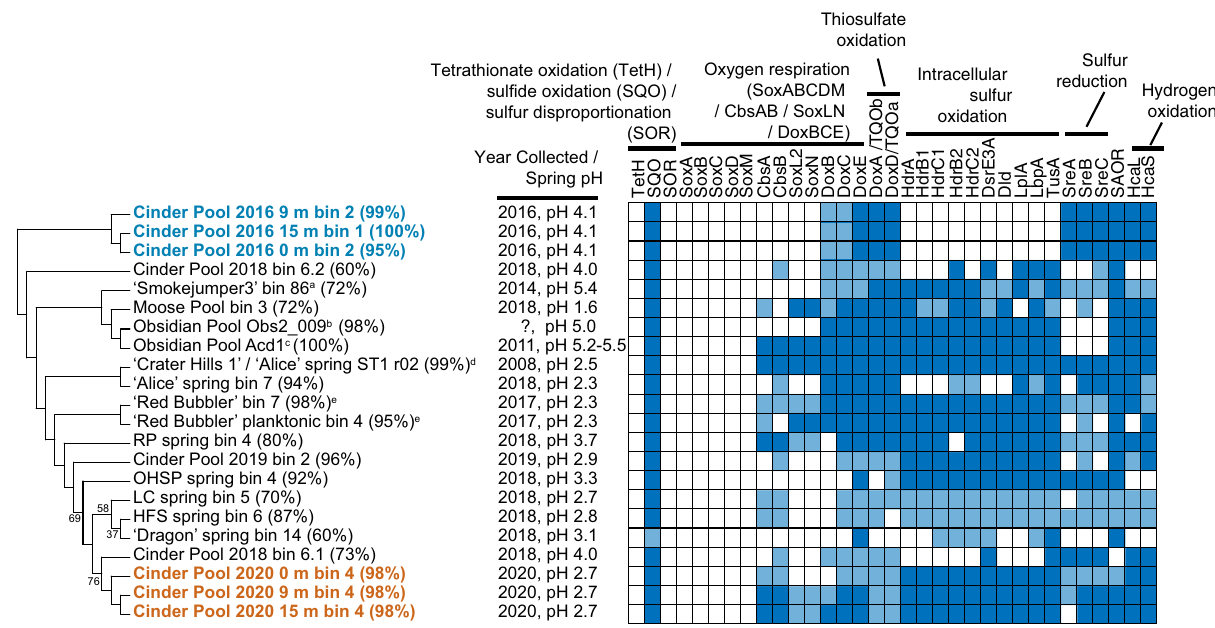
Fig. 5 Metabolic reconstructions of uncharacterized Sulfolobales metagenome-assembled genomes (MAGs) recovered from Cinder Pool (CP) and other Yellowstone National Park (YNP) hot springs. Uncultured Yellowstone Sulfolobales (UYS) MAGs are shown in a cladogram on the left in the same order as the phylogenomic tree in Fig. 4a. MAGs recovered from CP waters in 2016 are highlighted in blue and those from 2020 are highlighted in orange. MAGs with superscript labels were recovered from YNP hot spring sediments in previously published studies as follows ( a 33 ; b 35 ; c 34 ; d 32 ; e 26 ; note the single MAG generated from a water community of ‘ Red Bubbler ’ spring). All other MAGs were recovered from YNP hot spring sediments as part of our other studies. The name of the spring is given fi rst, followed by the MAG identi fi er, and the estimated completeness of the MAG is in parentheses. The year of sample collection and spring pH is given in the column in the middle. The heatmap to the right of the labels shows the presence of genes encoding proteins involved in sulfur cycling within each MAG, with protein names and functions listed at the top of the heatmap. White cells indicate the lack of gene presence, dark blue cells indicate gene presence in the MAG, and light blue cells indicate the presence of homologs identi fi ed in the metagenome assemblies that are attributable to the UYS (>90% amino acid identity to other homologs from UYS MAGs), but that was only present on unbinned contig sequences. Proteins are grouped based on their functionalities and associations in complexes. TetH (tetrathionate hydrolase), SQO sul fi de:quinone oxidoreductase, SOR sulfur oxygenase reductase, SoxABCD Sulfolobus oxidase, SoxM Sulfolobus oxidase, CbsAB cytochrome b 558/566, SoxLN cytochrome ba complex, DoxBCE Desulfurolobus oxidase, DoxAD/TQOab Desulfurolobus oxidase/thiosulfate-quinone oxidoreductase, HdrAB1C1B2C2 (heterodisul fi de reductase), DsrE3 DsrE3 sulfurtransferase, Dld dihydrolipoamide dehydrogenase, LplA lipoate-protein ligase A, LbpA lipoate binding protein A/glycine cleavage system H protein, TusA tRNA 2-thiouridine synthesizing protein A, SreABC sulfur reductase, SAOR sul fi te:acceptor oxidoreductase, HcaLS [NiFe]-hydrogenase group 1 g. SoxEFGHI and FoxABCDEFGH (ferrous iron oxidation) gene sets were also investigated, but not identi fi ed in any of the MAGs and not shown here for brevity. A complete description of the enzymes/proteins found in individual UYS MAGs is provided in Supplementary Data